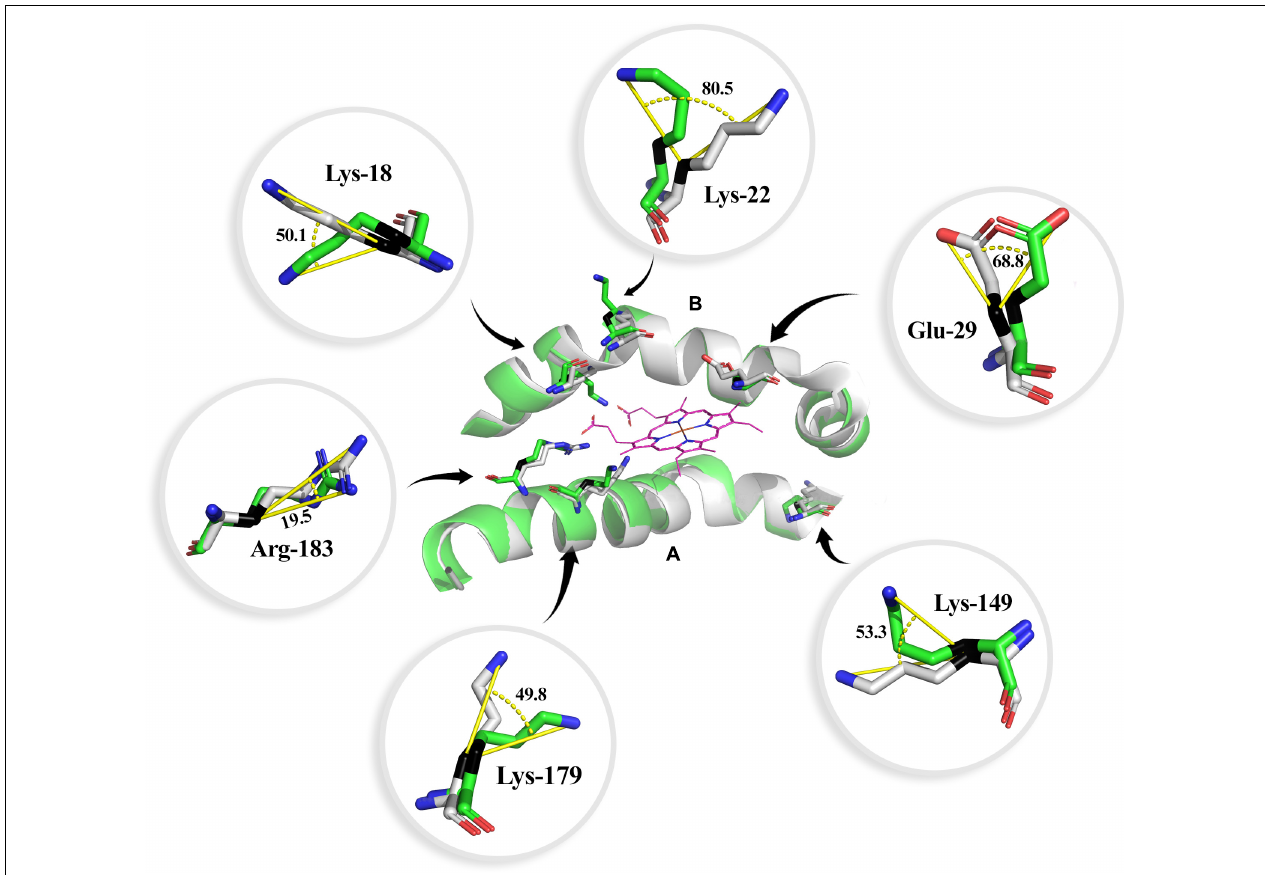
FIGURE 4 | Heme group interaction site of the bottlenose dolphin heme oxygenase 1 (HO-1) alignment to human HO-1. Angle of rotation is shown in degrees. The carbon β is indicated in black. The distal (A) and proximal (B) helix are shown. Carbon atoms are shown in green for bottlenose dolphin and gray for human (except for the heme group, in which carbon atoms are shown in purple), nitrogen atoms in blue, and oxygen in red.